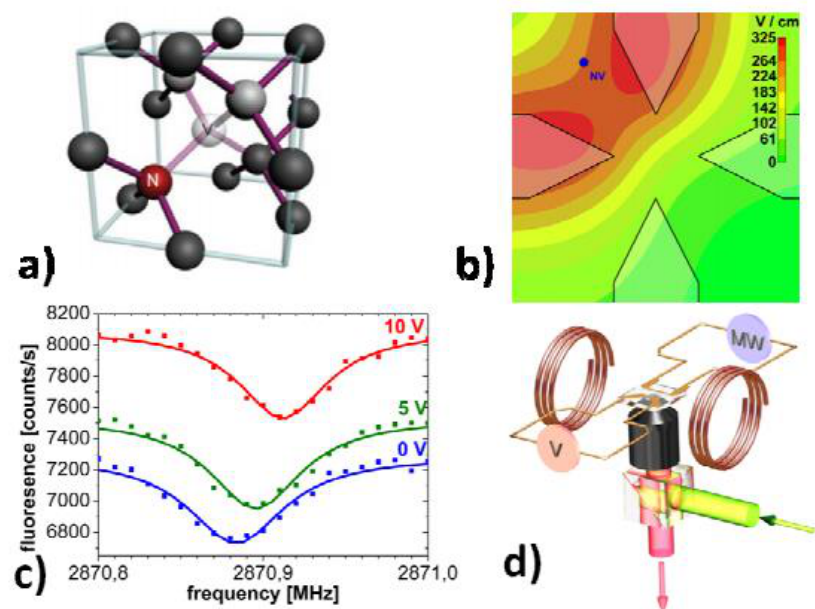
Figure 15. ( a ) Schematic drawing of the NV center; ( b ) simulated electric field 6 µ m below the microstructure (where the NV is located) for 1 V voltage applied; ( c ) observed shift of the ODMR resonance lines for different voltages applied; ( d ) schematic of the used confocal setup with Helmholtz coils for magnetic field alignment. Reprinted with permission from [10], Springer, 2011.